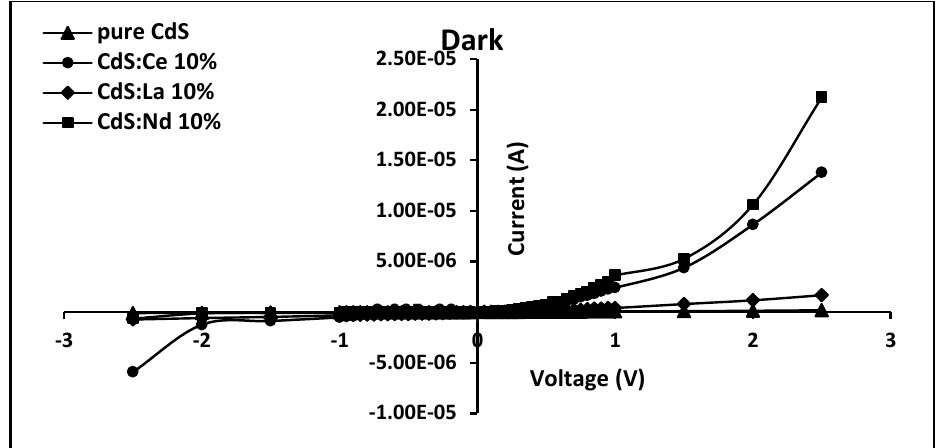
Fig.6: I-V characteristics of CdS and (Ce, La and Nd) doped CdS at 10% in dark condition.